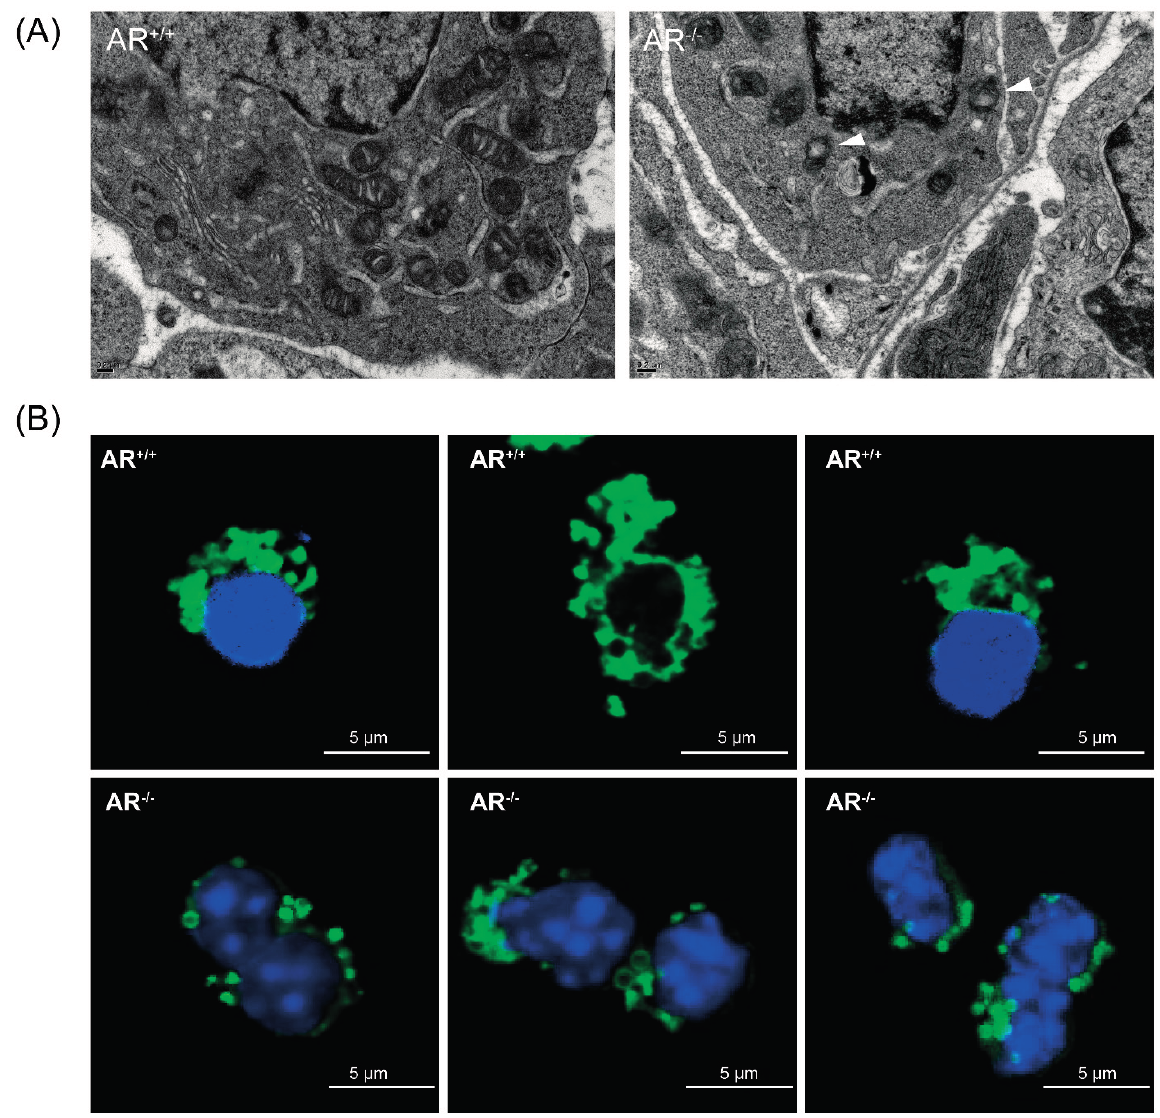
Figure 4. Alteration of mitochondrial morphology in granulosa cells of AR − / − mice. ( A ) Mitochondrial morphology in granulosa cells of AR − / − mice was visualized by transmission electron microscopy (TEM). Representative electron micrograph of mitochondria from control ( AR +/+ ) granulosa cells, showing bean-shaped structures with numerous transversely orientated cristae enveloped by an intact outer membrane; AR − / − granulosa cells displayed small spherical structures with fewer and disarrayed cristae, and the presence of large vacuoles in mitochondria (white arrowhead); ( B ) Mitochondrial morphology in granulosa cells of AR − / − mice was visualized by immunofluorescence. Granulosa cells collected from AR +/+ and AR − / − mice were labeled with MitoTracker Green to visualize mitochondrial localization and co-stained with 4',6'-diamidino-2-phenylindole (DAPI) to visualize nuclei. Representative confocal sections of granulosa cells were shown. Mitochondria in granulosa cells from AR − / − mice displayed aggregating distribution pattern and small spherical